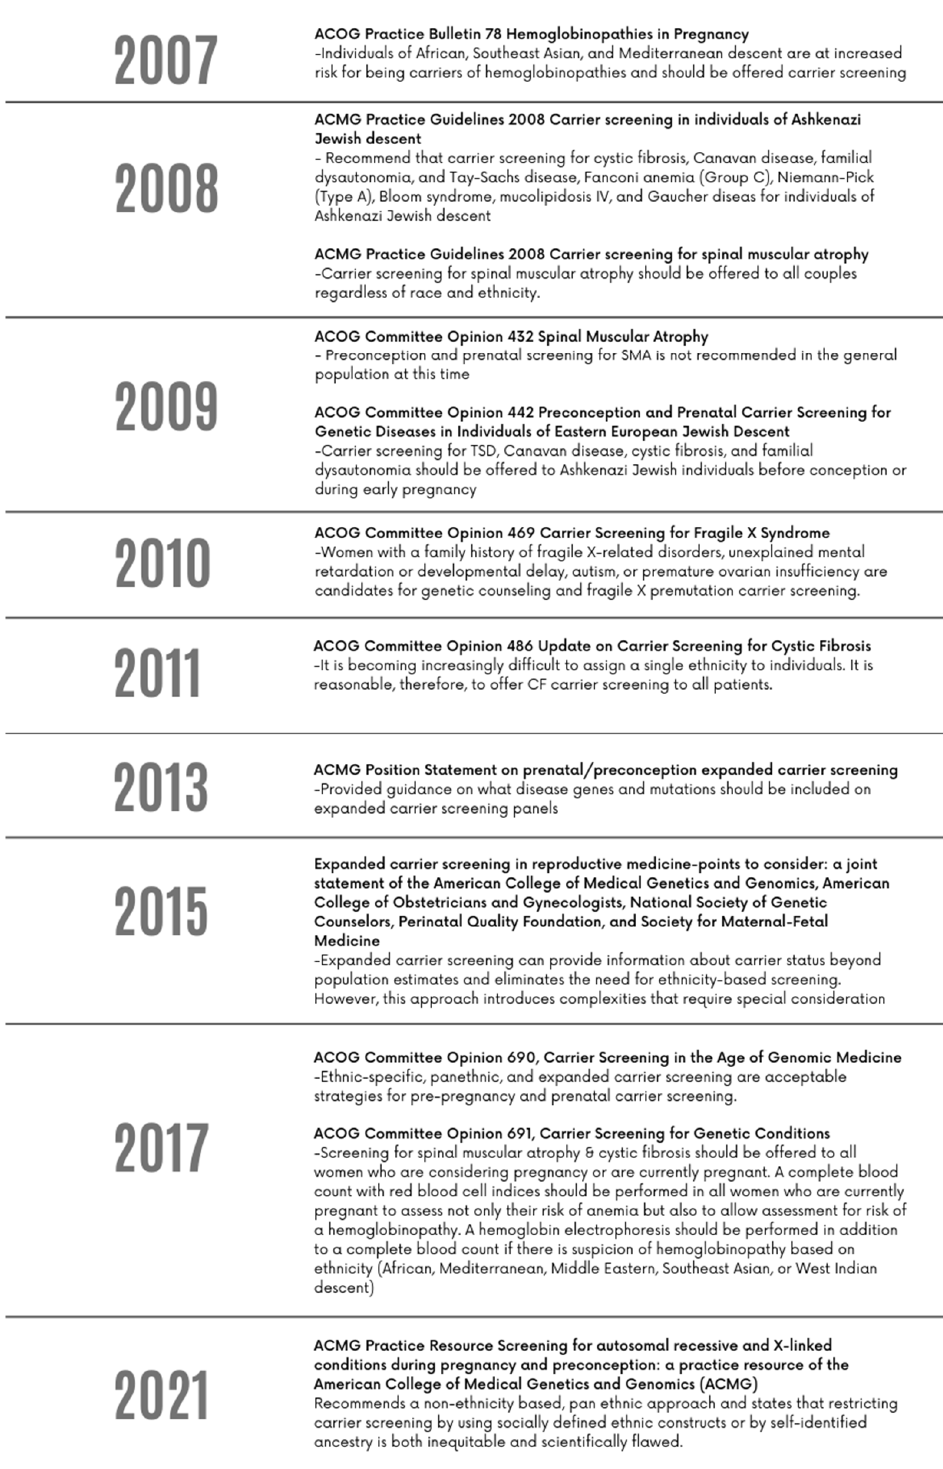
Figure 2. A History of Carrier Screening Guidelines in the United States [4,52,56,73–94]. In 2015, a joint statement entitled “Expanded Carrier Screening in Reproductive Medicine—Points to Consider” was issued by ACMG, ACOG, the National Society of Genetic Counselors (NSGC), Perinatal Quality Foundation (PQF), and the Society for Maternal-Fetal Medicine (SMFM) [93]. This early document acknowledged that ECS provides a more comprehensive risk assessment for our increasingly multiethnic